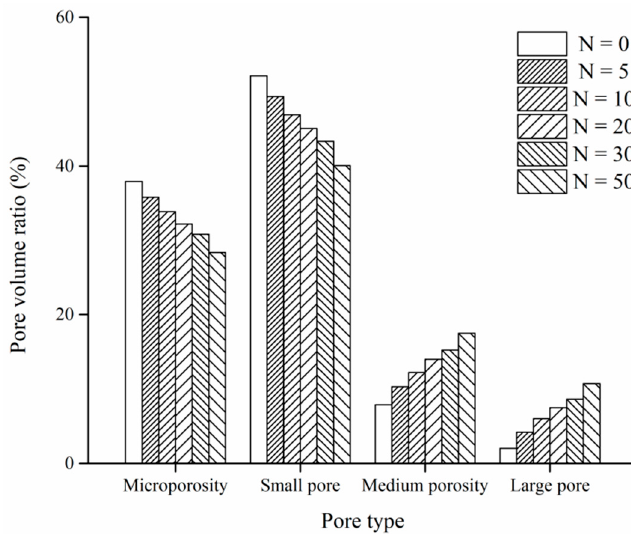
Figure 12. Pore volume distribution.